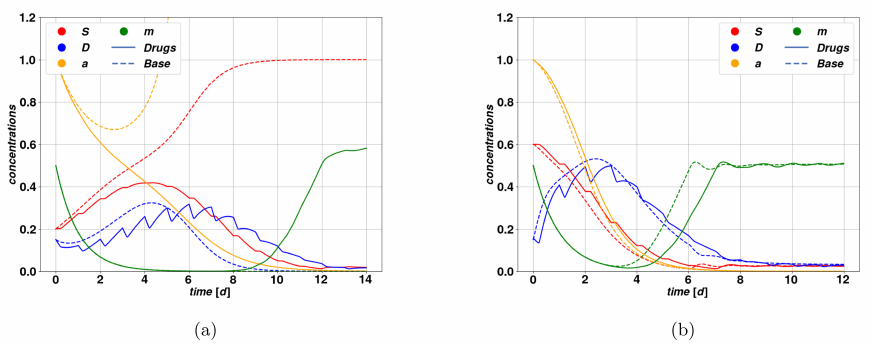
Figure 6. Trajectories overlay with the active cytostatic treatment case (solid lines) together with the untreated case (dashed lines). In all figures, we keep the same codes of colors as previously for S , D , a and m . In these examples, we assume the drug action to operate by reducing the mitotic factor λ . In ( a ) on the left the treatment is successful and prevents a dangerous proliferation associated with divergent stem cell activator a , and consequent population overtaking of CSCs over DCs. The trajectories in ( b ) on the right depict an overshoot case, where the untreated tumor undergoes autonomous regression, and the treatment is ineffective both in reducing the overshoot and enhancing the regression. The system and drug parameters are given in Tables